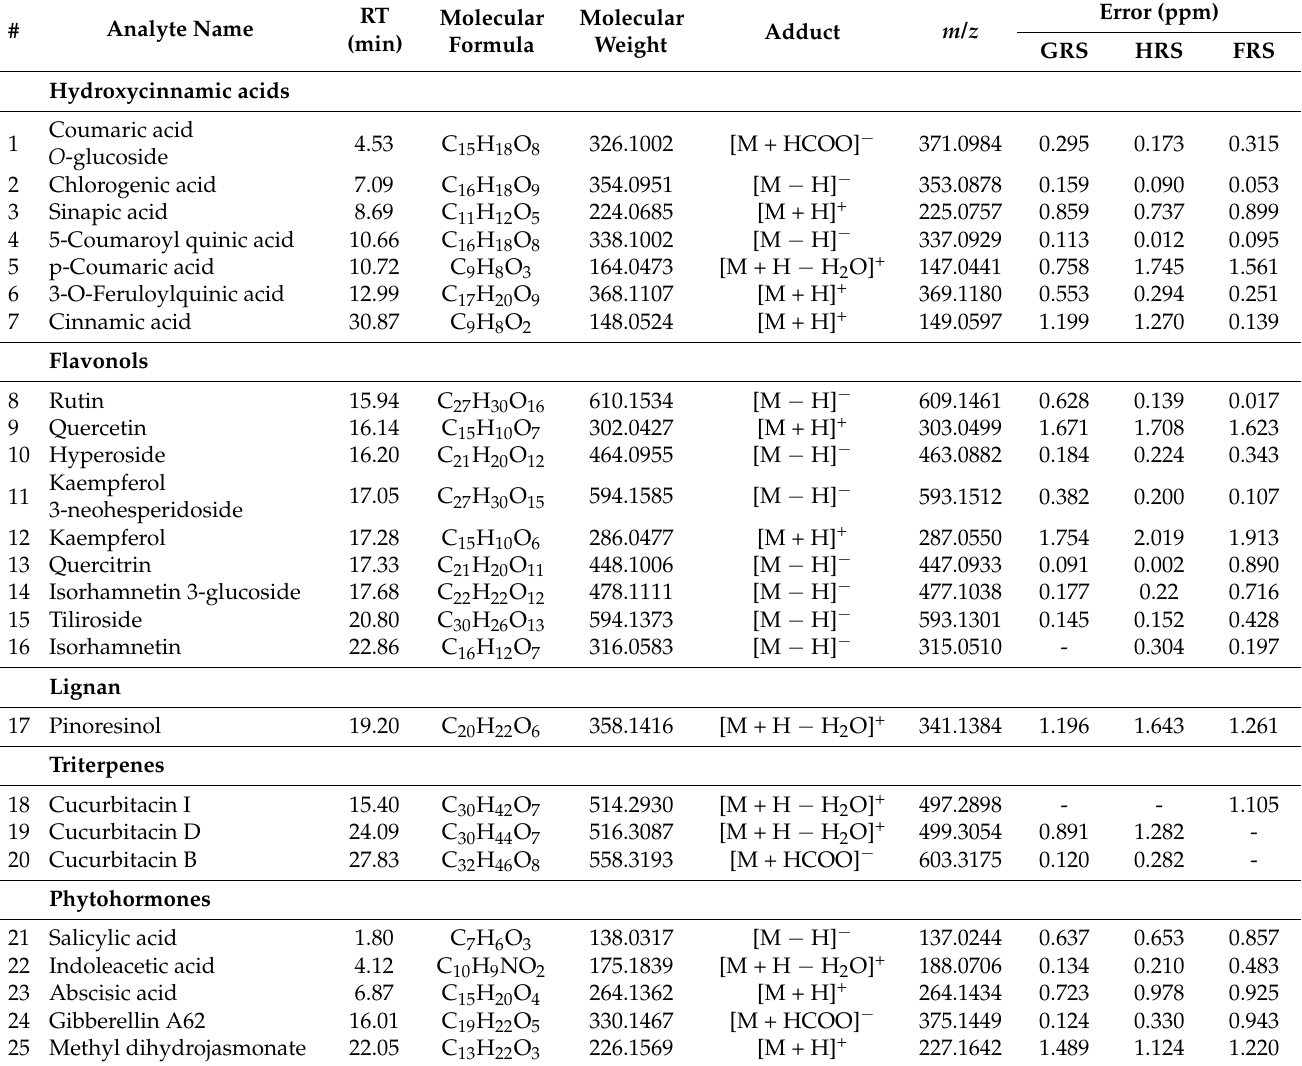
Table 1. Identification of the phytochemicals and phytohormones of Coccinia grandis fruits at different stages of